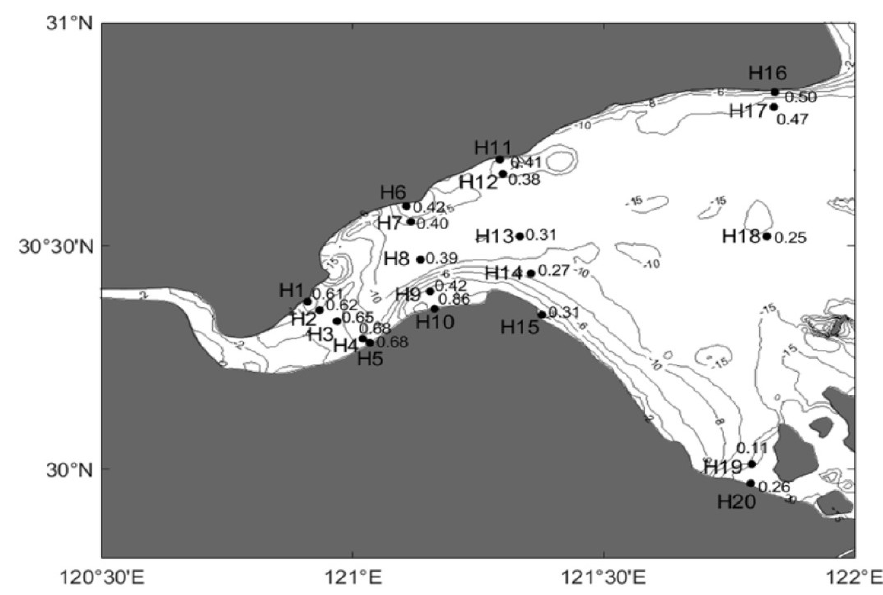
Figure 4. The water depth at the Hangzhou Bay stations (H1–H20) and the point of the distribution of skewness from June to September 2020.